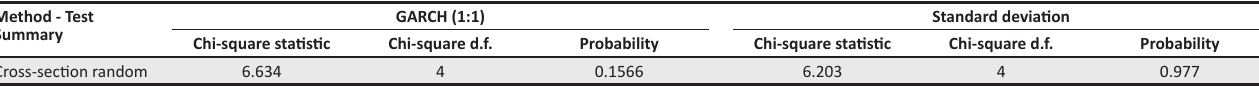
TABLE 10: Random effects – Hausman